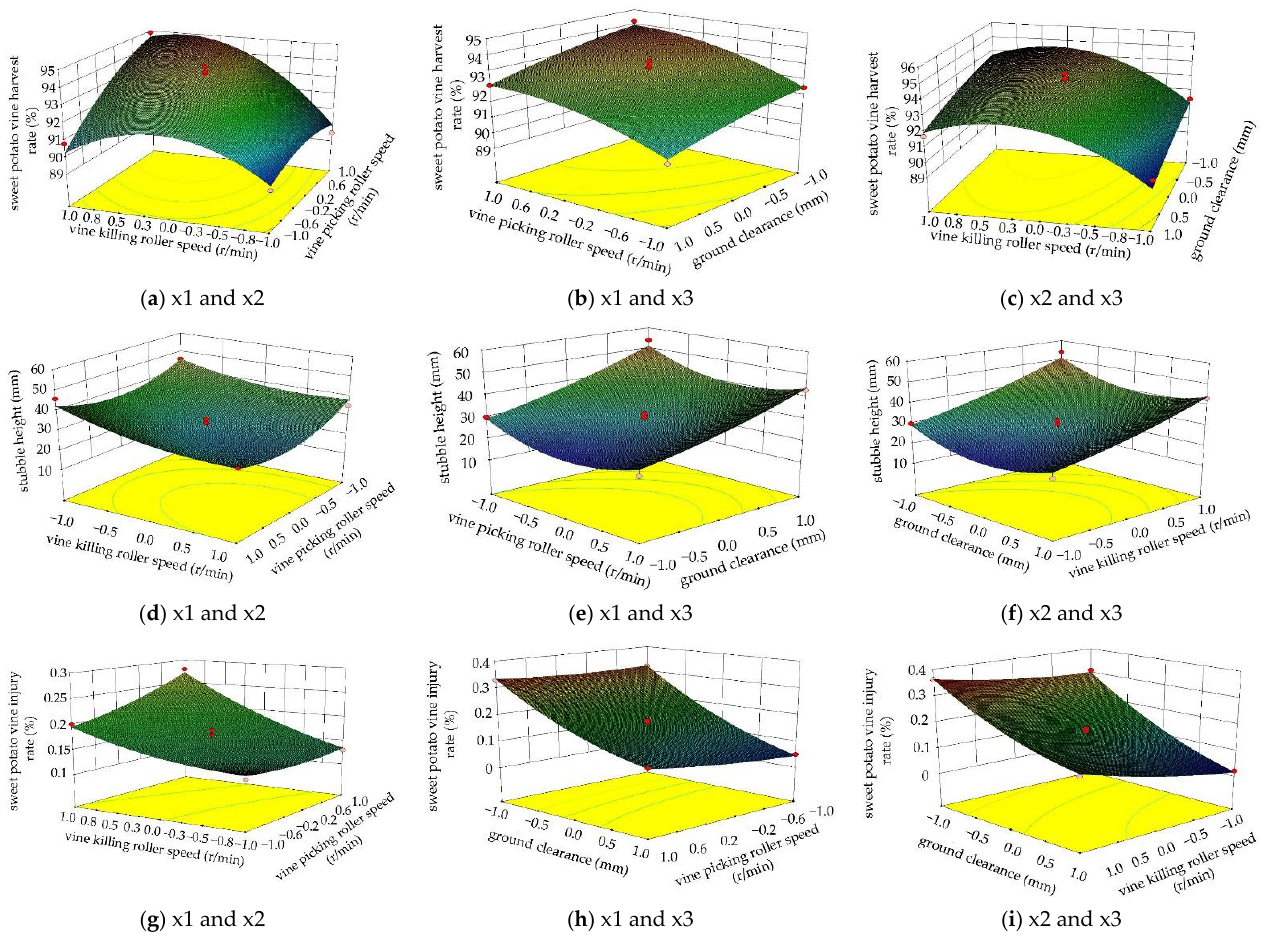
Figure 14. The influence of interaction factors on the response value.